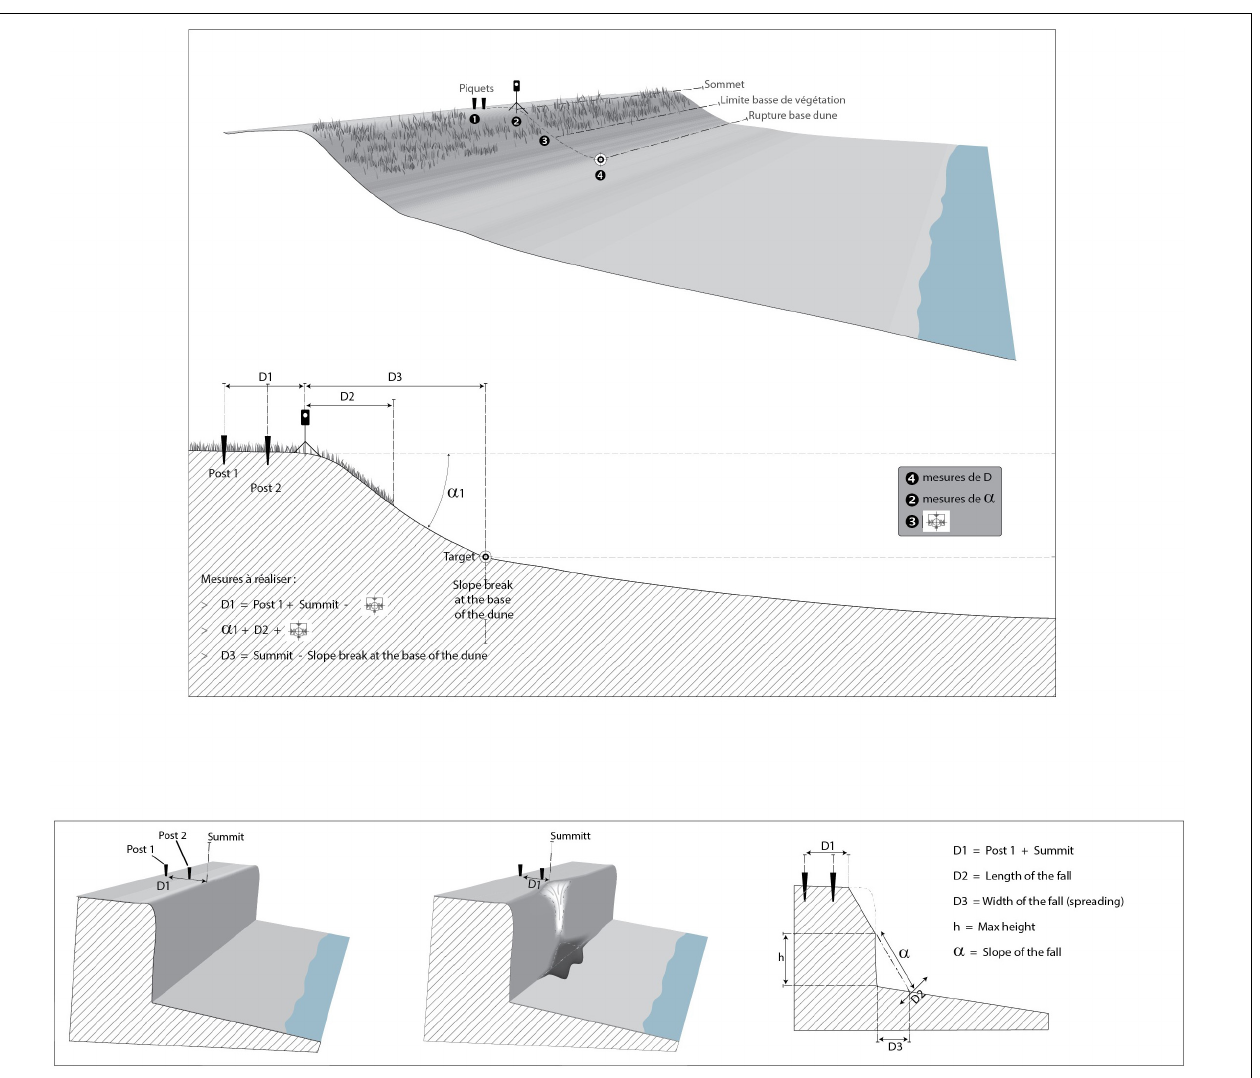
FIGURE 3 | Example of measurements carried out in the OSIRISC project (Hénaff, 2017; Marcel et al.,